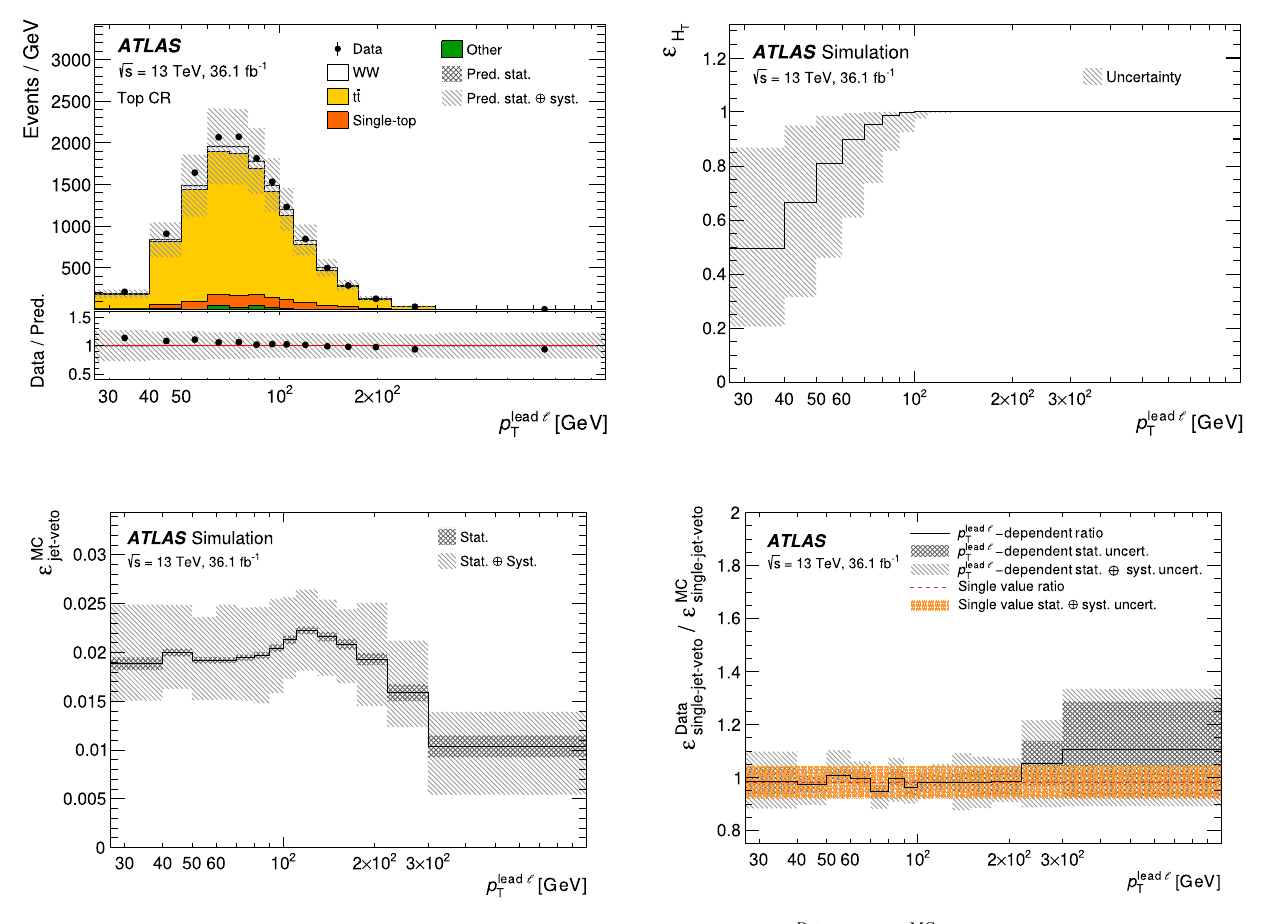
Fig. 2 Inputs to the partly data-driven method for the top background estimate as a function of the p T of the leading lepton: (upper left) events selected in data and in simulation in the top CR, with a requirement of H T > 200 GeV applied, (upper right) the H T cut efficiency (cid:14) H left) the MC-based jet-veto efficiency (cid:14) MC